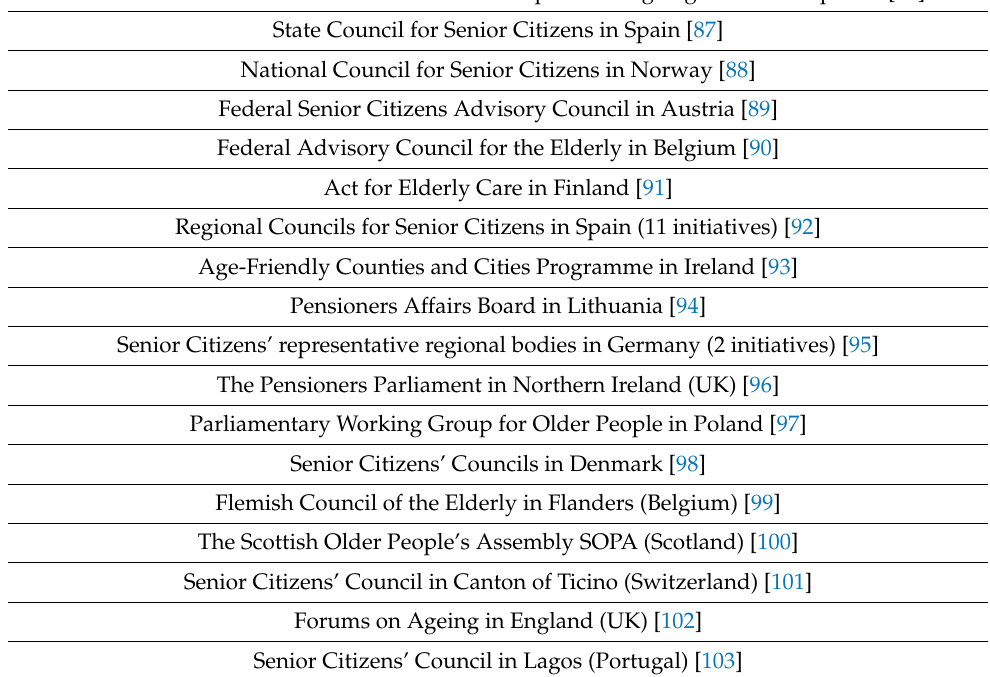
Web links to the 37 selected participatory initiatives. For further information, see Falanga et al., 2015